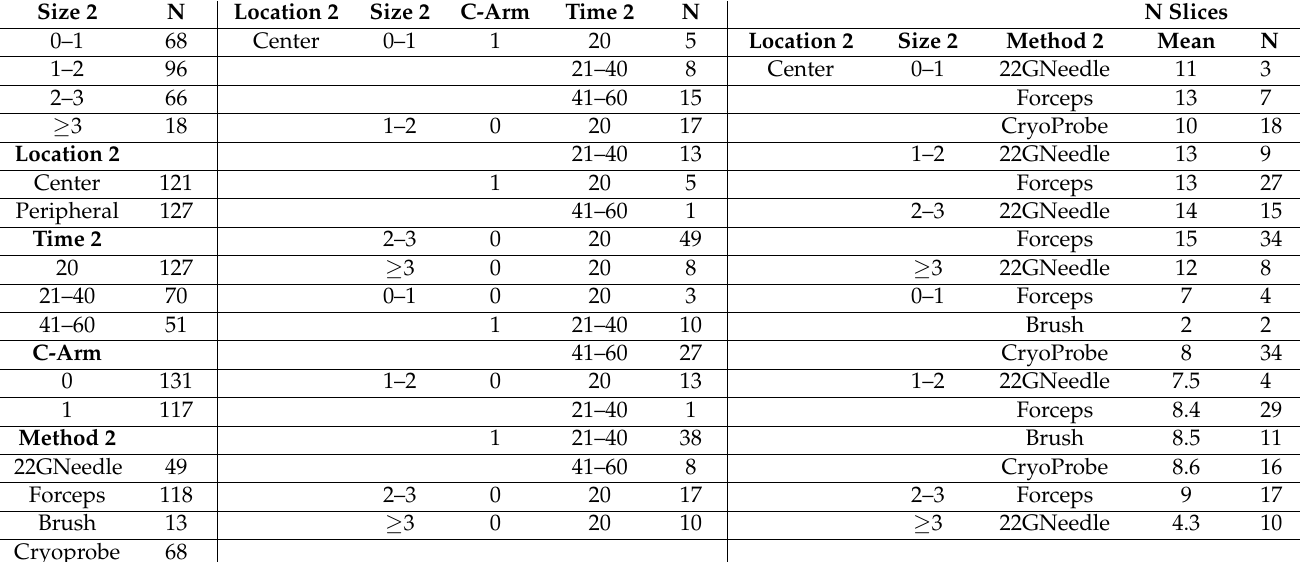
Table 1. Individual and cross-tabulation of the six parameters of interest: tumor size (cm) and location, operative time (min), use of C-Arm, method of penetration, and the number of slices. Tumor location and lesion size are presented twice in the